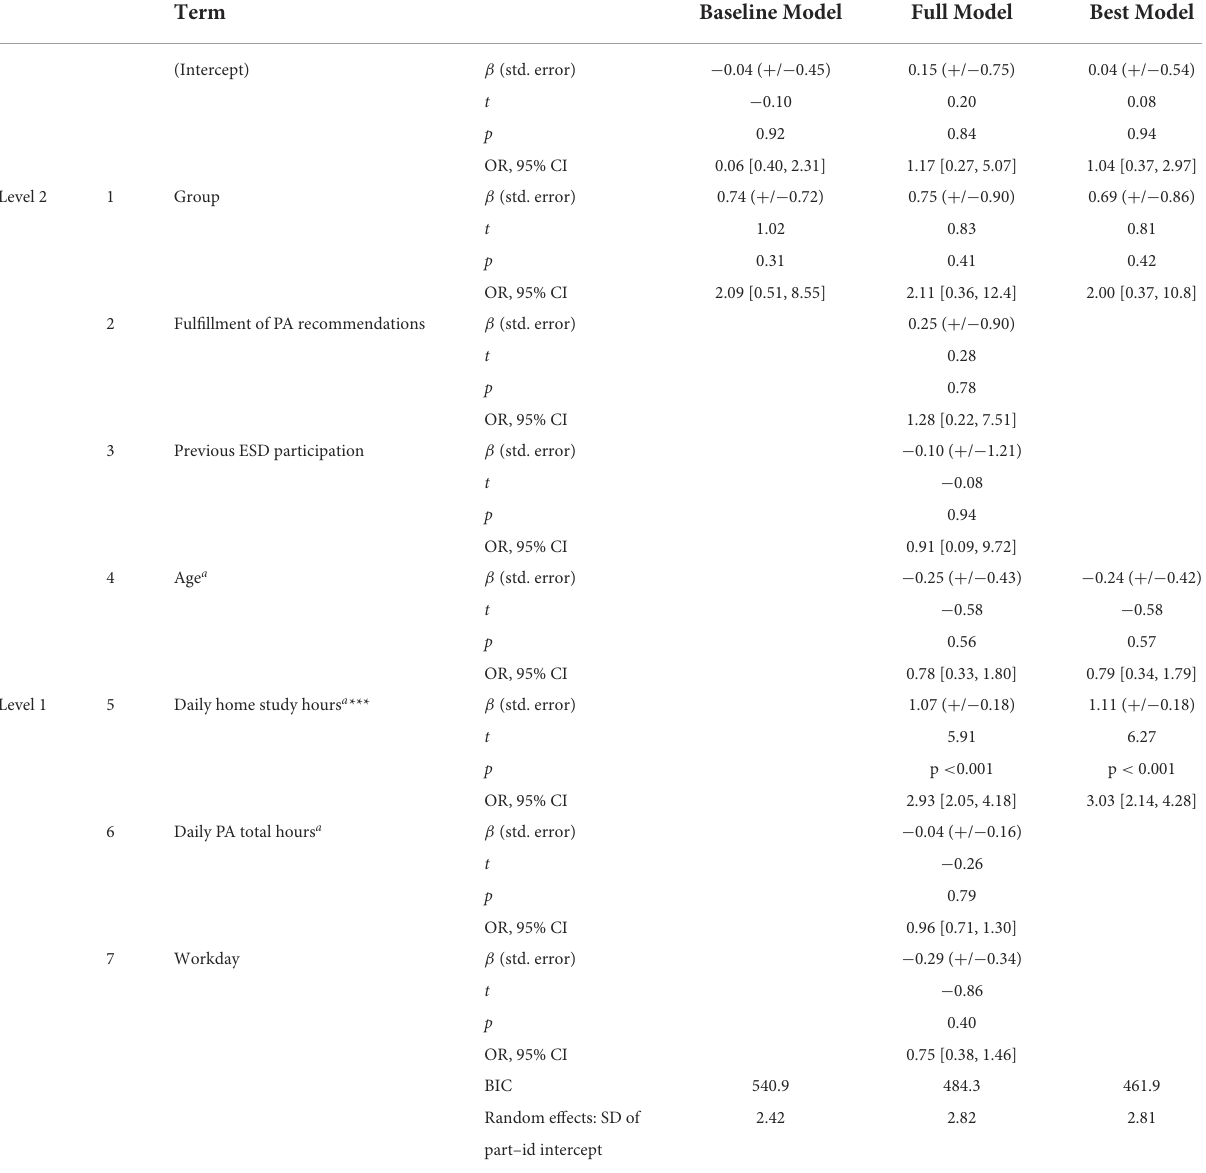
TABLE 3 Overview of the results of the binary logistic structural hierarchical model for the Baseline Model, Full Model, and Best Model. Term Baseline Model Full